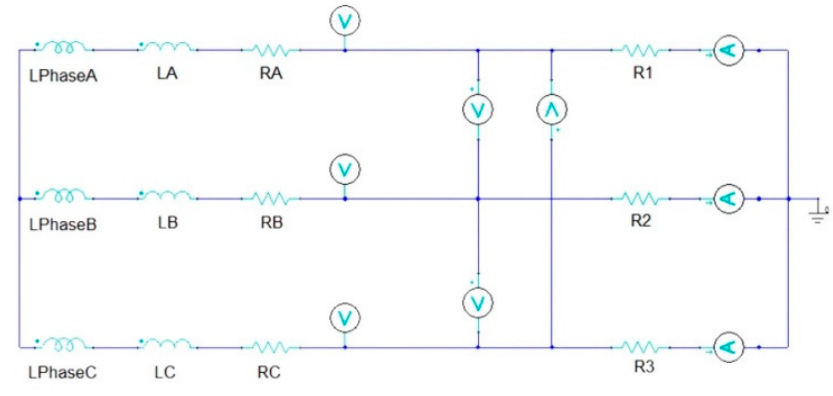
Figure 9. External circuit of hydro-generator.